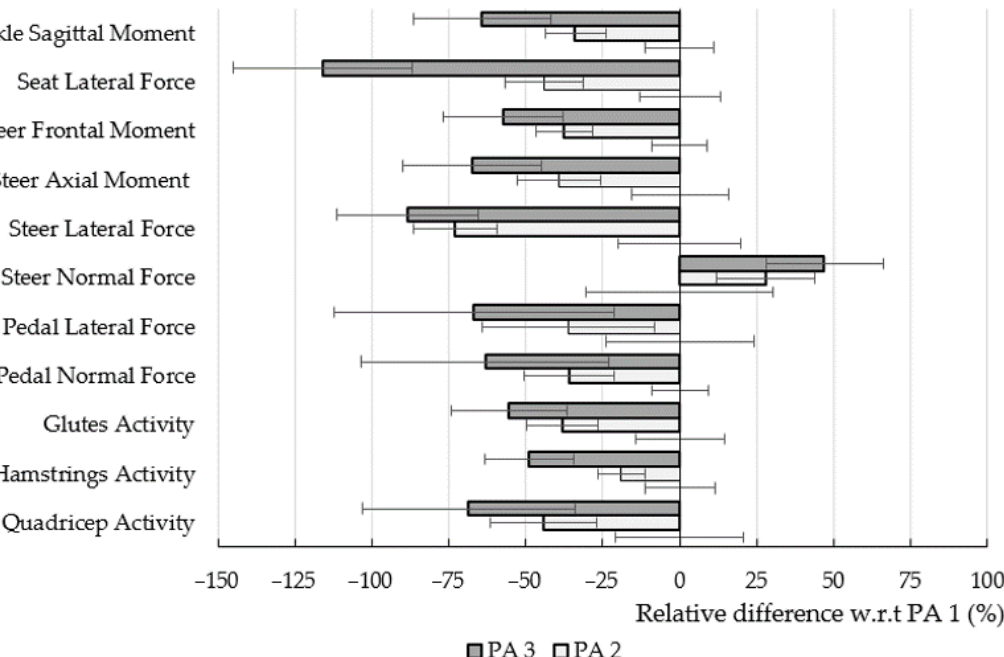
Figure 8. Significant differences based on the level of PA for the power